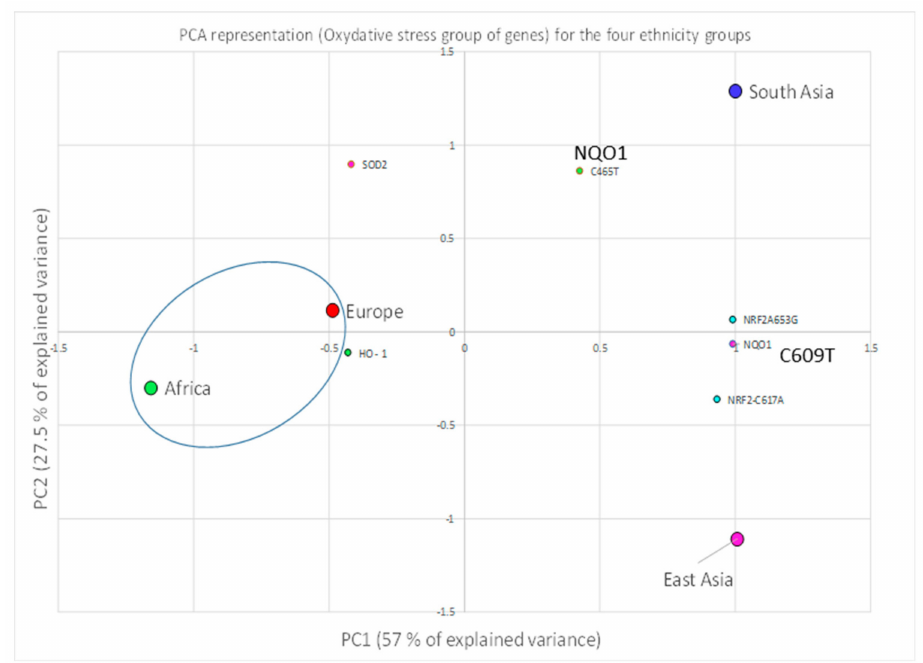
Figure 5. PCA representation of the relative risk of unfavorable mutation of the genes belonging to the group of oxidative stress. Both the ethnicity groups (cases) and the genes (original variables) are represented in the PC